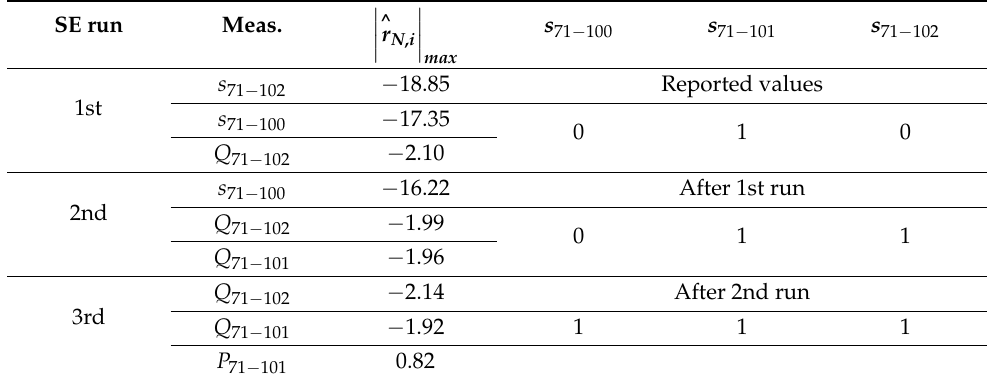
Table 7. Bad data analysis to identify the actual status of switching